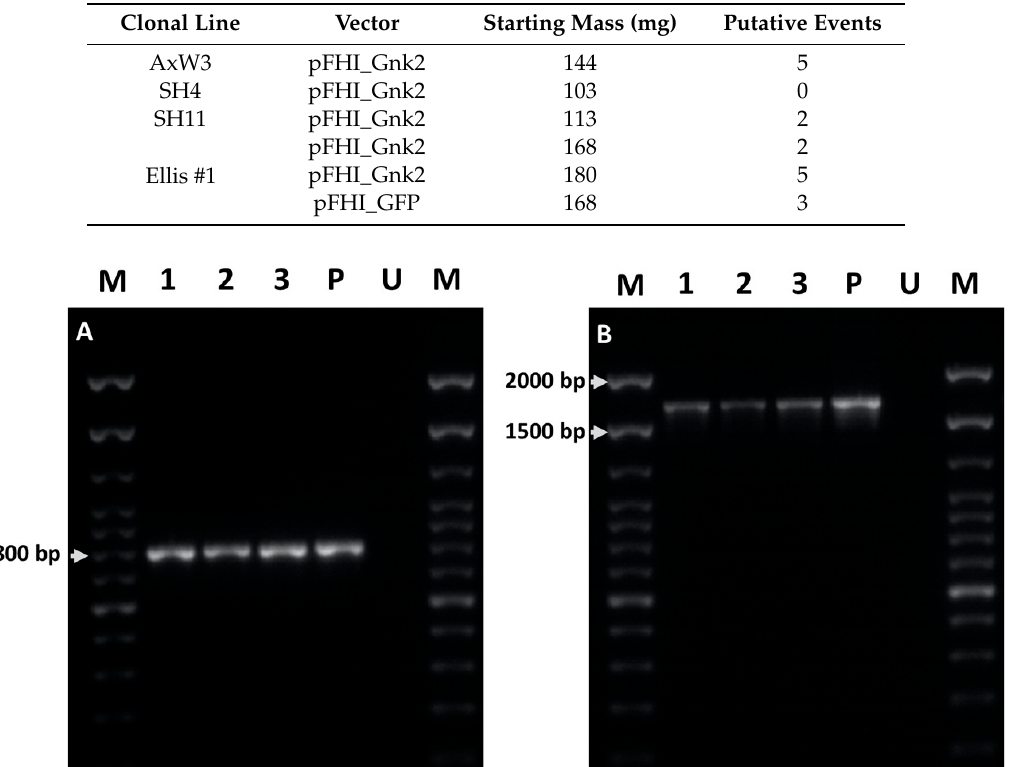
Figure 7. PCR analysis of American chestnut transgenic lines. ( A ) PCR amplification using